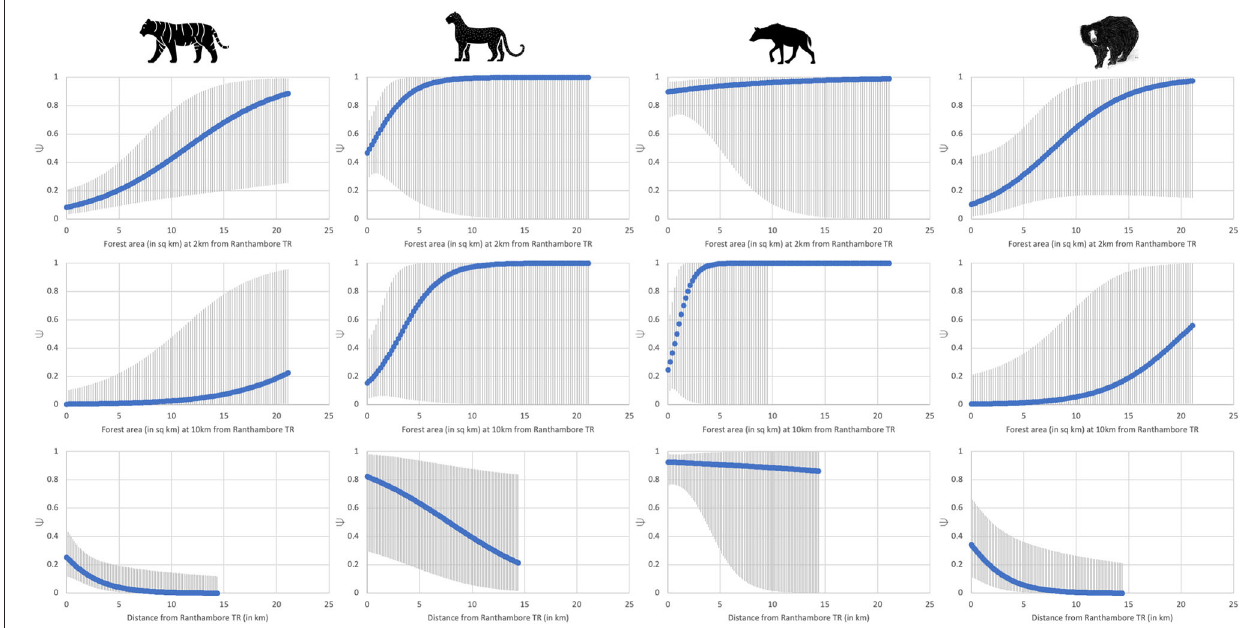
FIGURE 2 | All four target species’ 9 were positively associated with forest area, with tiger habitat-use significantly associated with forest area. 9 decreased with increasing distance from Ranthambore Tiger Reserve for all four